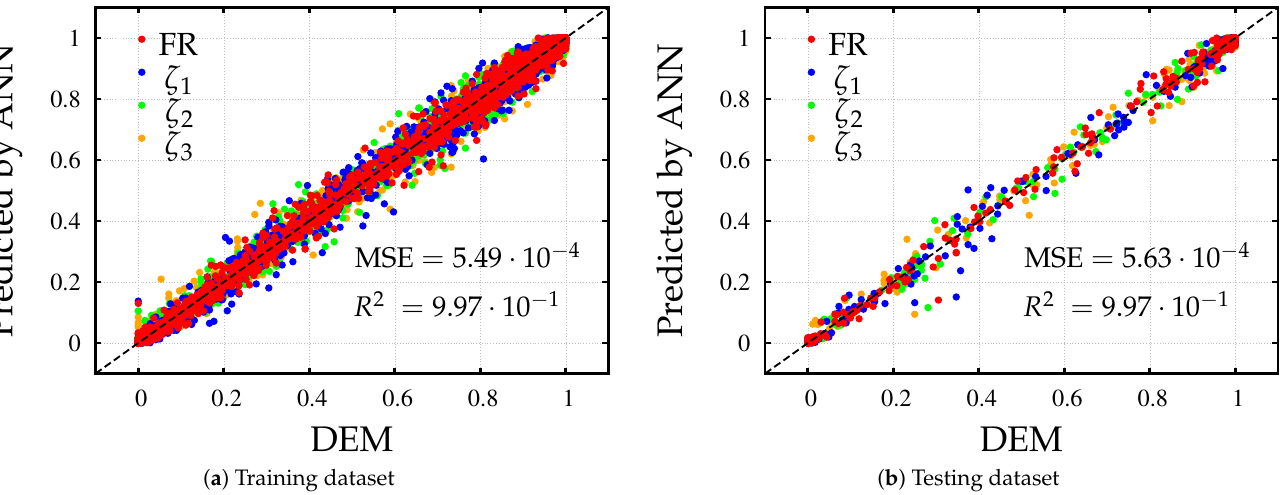
Figure 3. ANN predictions vs. DEM results concerning the fragmentation ratio (FR) and the fragment size parameters ζ i for ( a ) the training dataset and ( b ) the testing dataset. The number of data points for each output quantity in the training and the testing dataset is about 2700 and 300, respectively. The reference line is dashed and has a slope of